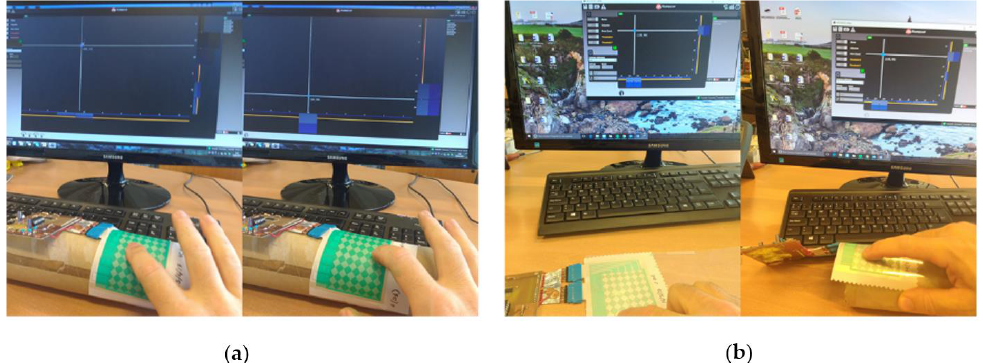
Figure 12. ( a ) Performance test on a curved surface touching two different points; and ( b ) performance test touching on the same point but on a flat and a curved surface, obtaining the same